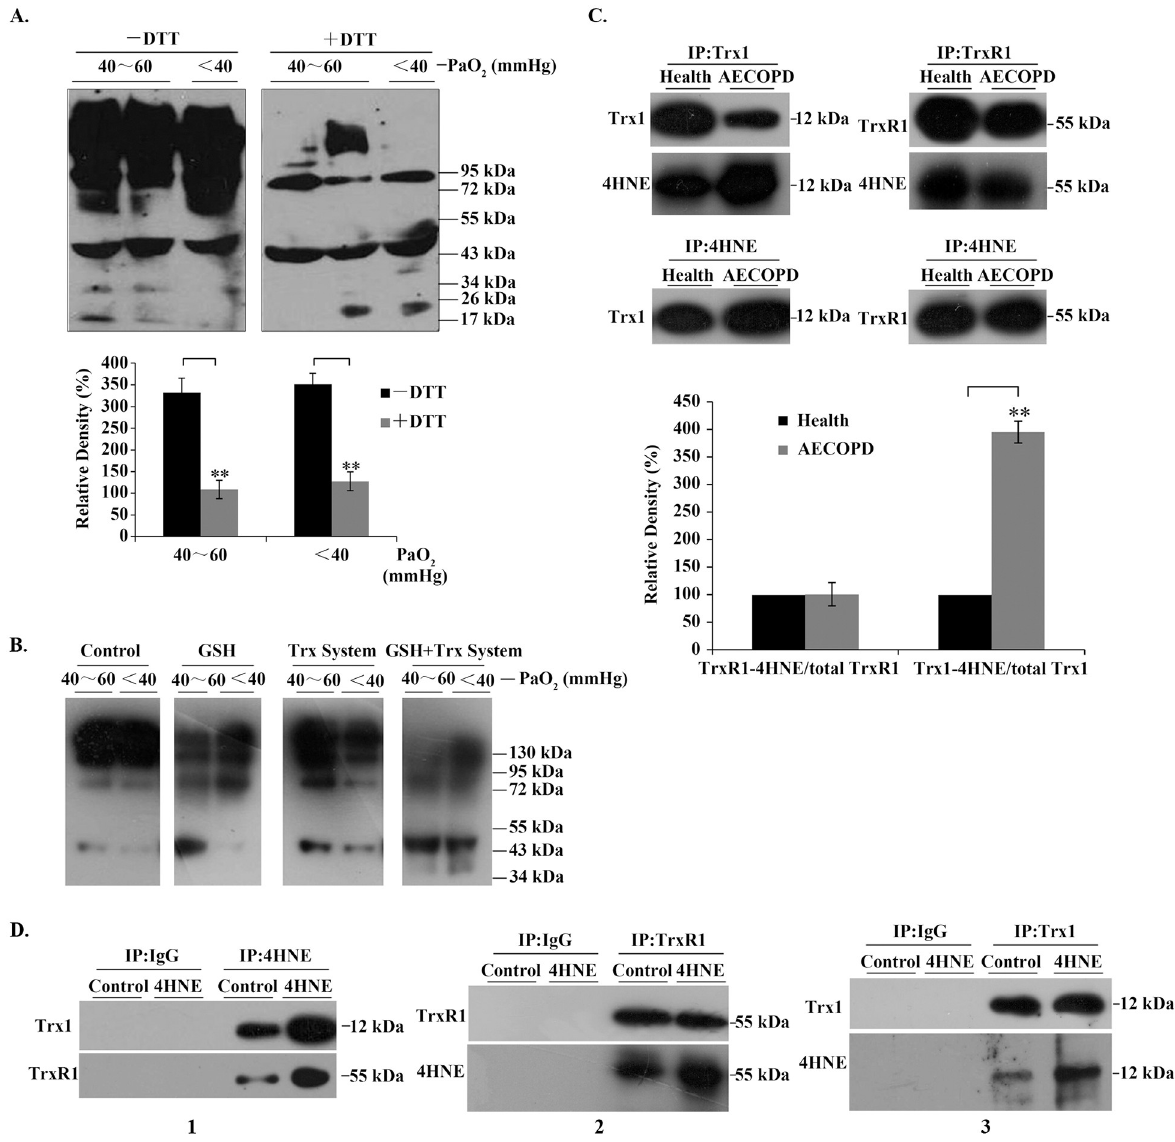
Fig 2. 4HNE-protein adducts in serum and in bronchial epithelial cells. ( A ) 4HNE-protein adducts in human serum. Representative Western blots (upper panel) and relative density values (bottom panel) for the bands in the upper panel. ( B ) Representative Western blots. Control, buffer;